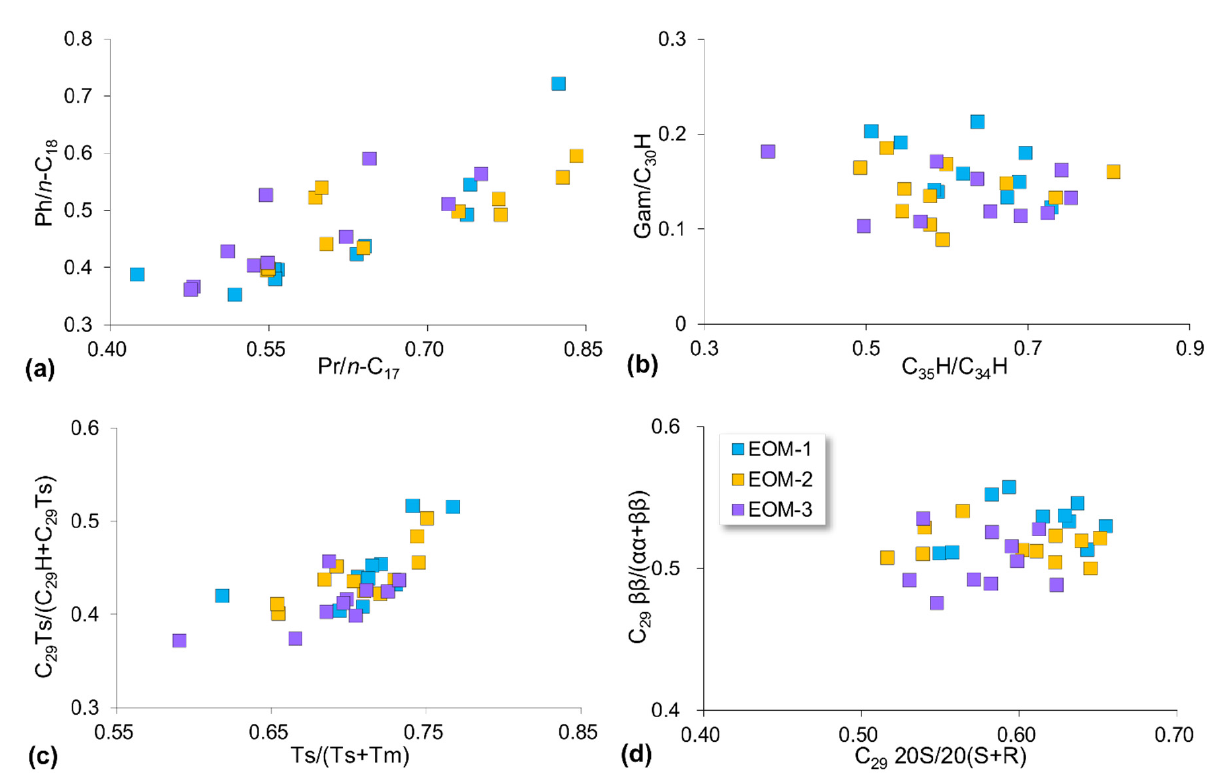
Figure 7. Correlations of molecular parameters derived from saturated hydrocarbon fraction in sequential extracts of the studied samples: ( a ) Pr/ n -C 17 vs. Ph/ n -C 18 ratios; ( b ) Gam/C 30 H vs. C 35 H/C 34 H; ( c ) Ts/(Ts + Tm) vs. C 29 Ts/(C 29 H + C 29 Ts); ( d ) C 29 steranes 20S/(20S + 20R) vs. ββ /( ββ + αα ).